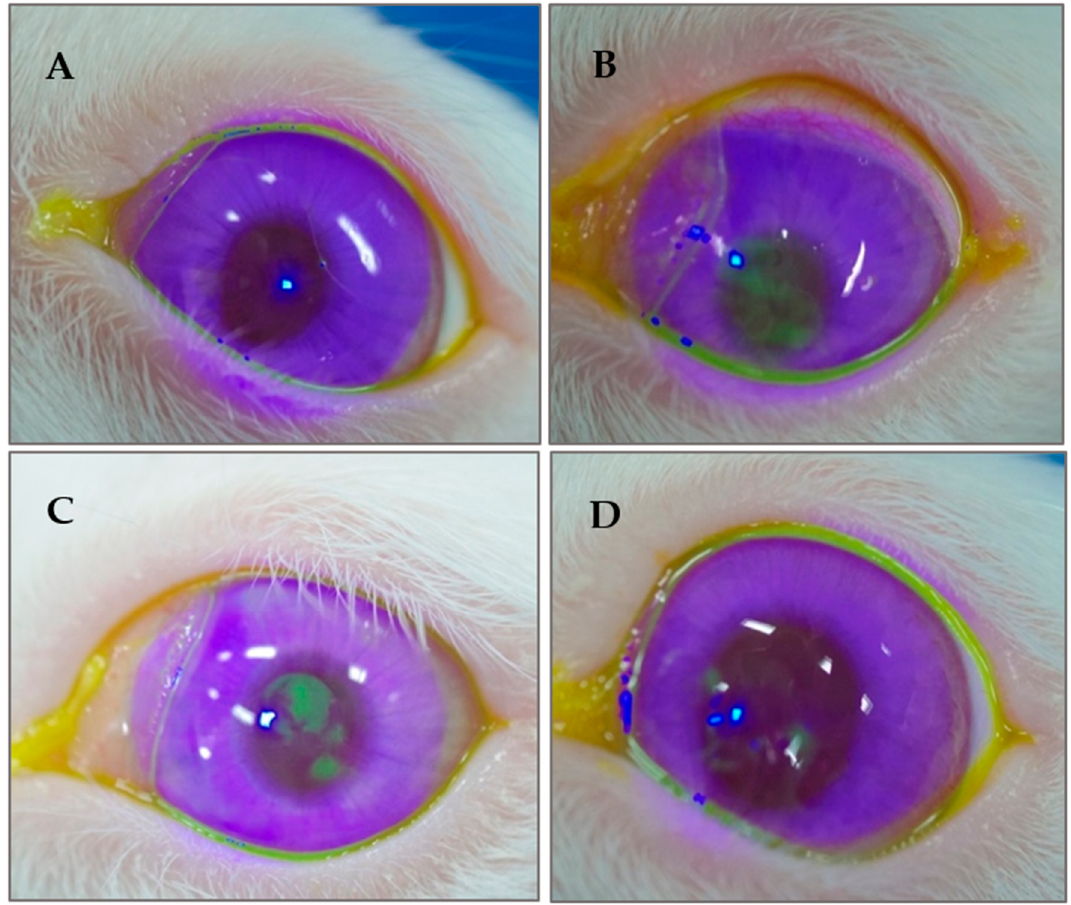
Figure 8. Slit-lamp images of the ocular surface of rabbits after fluorescence staining. ( A ) Control eye; ( B ) eye treated with 0.1% BAC (negative control; dry eye syndrome (DES) eye); ( C ) eye treated with only AT and ( D ) eye treated with AT-containing 0.1%